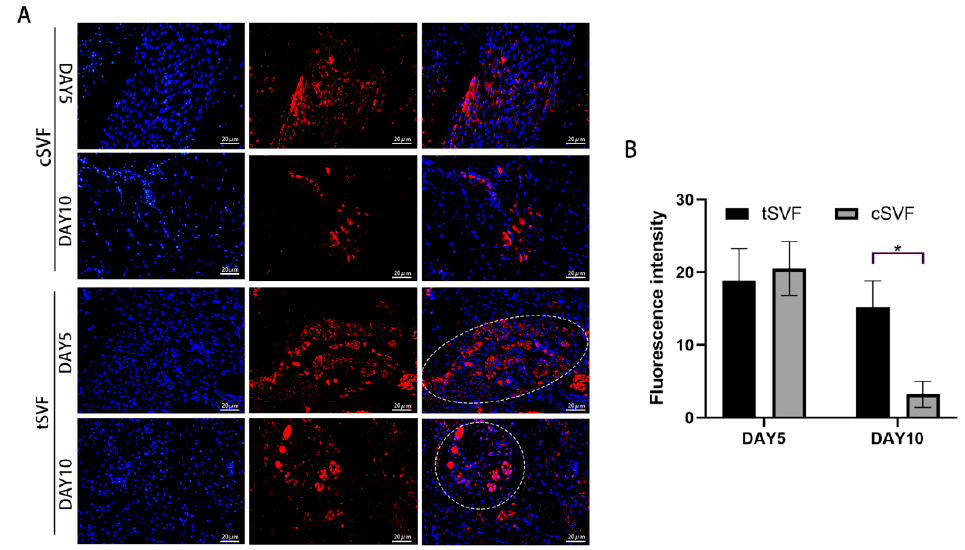
Figure 7. Fluorescence distribution of the cSVF and tSVF groups after 5 and 10 days of treatment. ( A ) shows the immunofluorescence image of DIL expression, with white circles indicating the area of concentrated fluorescence distribution; ( B ) shows the analysis of fluorescence intensity in the cSVF and tSVF group. ‘*’ indicates a statistical difference of p < 0.05. Cells in both cSVF and tSVF were found to be in a proliferative state, as represented